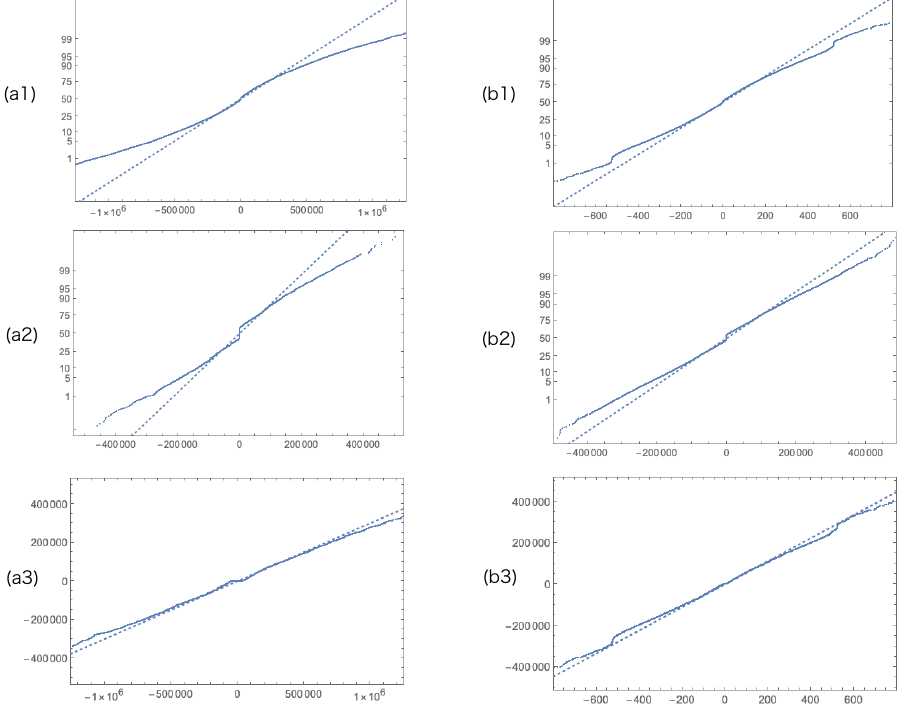
Figure 4. ( a1 ) TOPIX return of every 20 ticks(8897 records), morning, 1 December 2021; ( a2 ) sim- ulation result with (cid:101) = 0.003, δ = 0.05; ( a3 ) fitting of both; ( b1 ) USD/JPY return of every 20 ticks (21,314 records), 7 July 2014; ( b2 ) simulation result with (cid:101) = 0.005, δ = 0.05; ( b3 ) fitting of